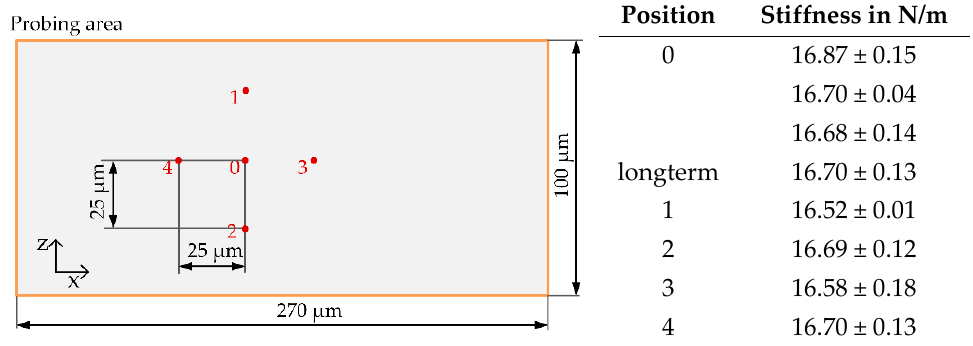
Figure 11. Eccentric test, ( left ): geometrical illustration of probing area, ( right ): stiffness measurement results in direction of motion of system W 3-1 C1.